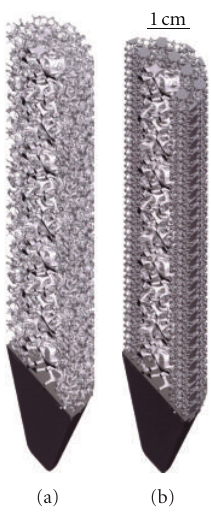
Figure 16: CAD-model examples of intramedullary rod or hip stem prototypes. (a) Section view for foam of higher density (and sti ff ness) surrounding foam of lower density (and sti ff ness) as in Figure 15(b). (b) Section view for foam of low-density core surrounded by high-density mesh (bone element in Figure 2(c))